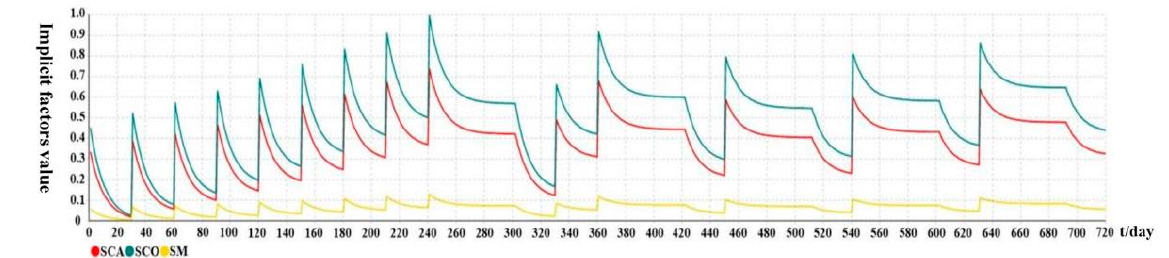
Figure 7. Variation trend of each implicit attitude over time under passive intervention.